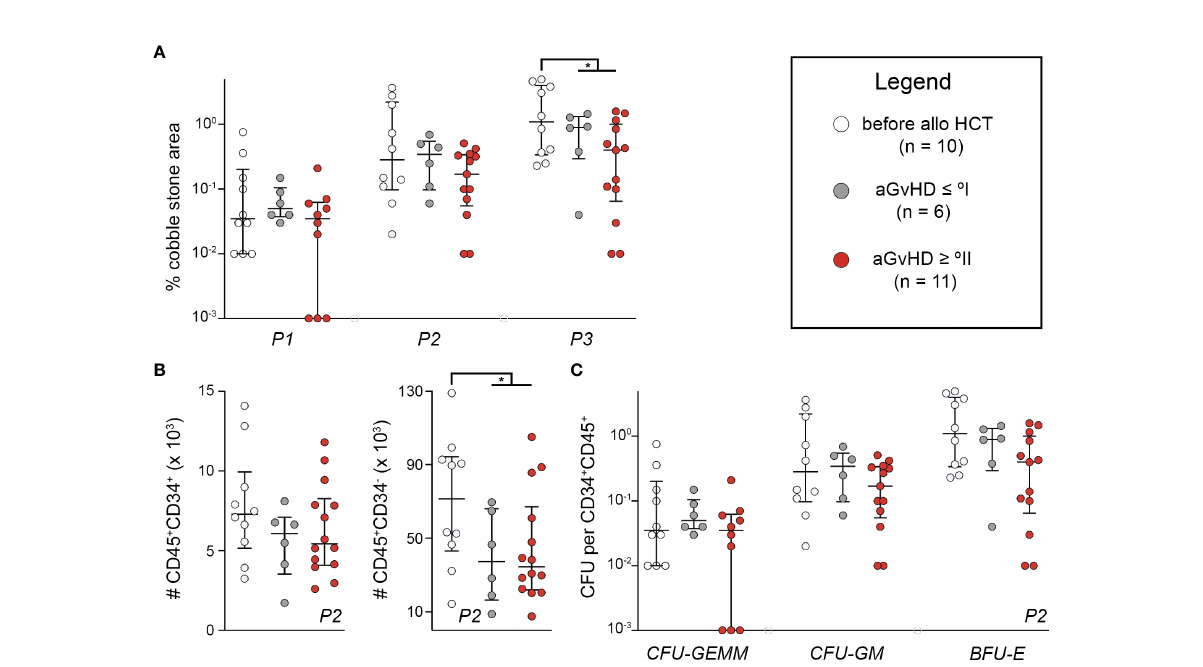
FIGURE 3 Endotypes of mesenchymal stromal cells relating to hematopoietic niche functions are lost during ex vivo expansion. (A) In CAFC test, cell layers were photographed using a Celigo S and scored for CAFC after 1, 2, and 3 weeks. Total area of CAFC of each coculture was calculated using ImageJ and compared with the total MSC layer area. (B) Additional cocultures of patient-derived MSCs P2 and healthy donor HSCs were detached after 2 weeks and quanti fi ed with a MACSQuant ™ after staining for CD34 and CD45. (C) Detached cells from coculture were also used for CFC assay. CFUs were analyzed with STEMvision ™ . The number of CFUs in proportion to seeded CD34 + CD45 + cells is shown. Graphs show individual values with median and interquartile ranges. The Mann-Whitney U-tests were used for statistical analyses. n, number; * P <